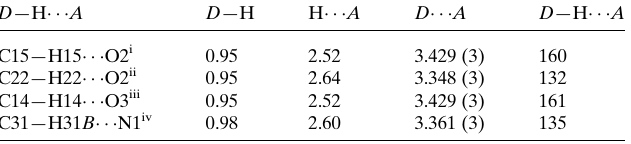
Table 2 Hydrogen-bond geometry (A˚ , (cid:2) ).